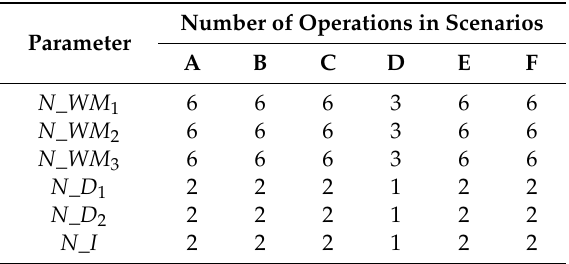
Table 5. Number of operations of devices in different scenarios.